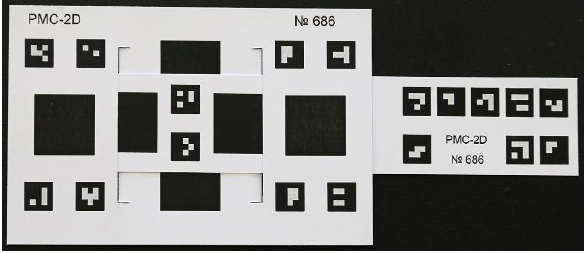
Figure 2. The marker PMC-2D for two-dimensional